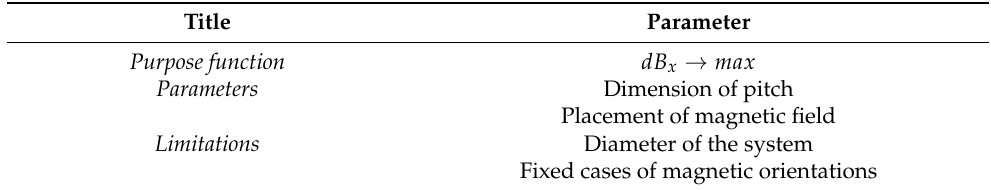
Table 1. Formulation of the optimization